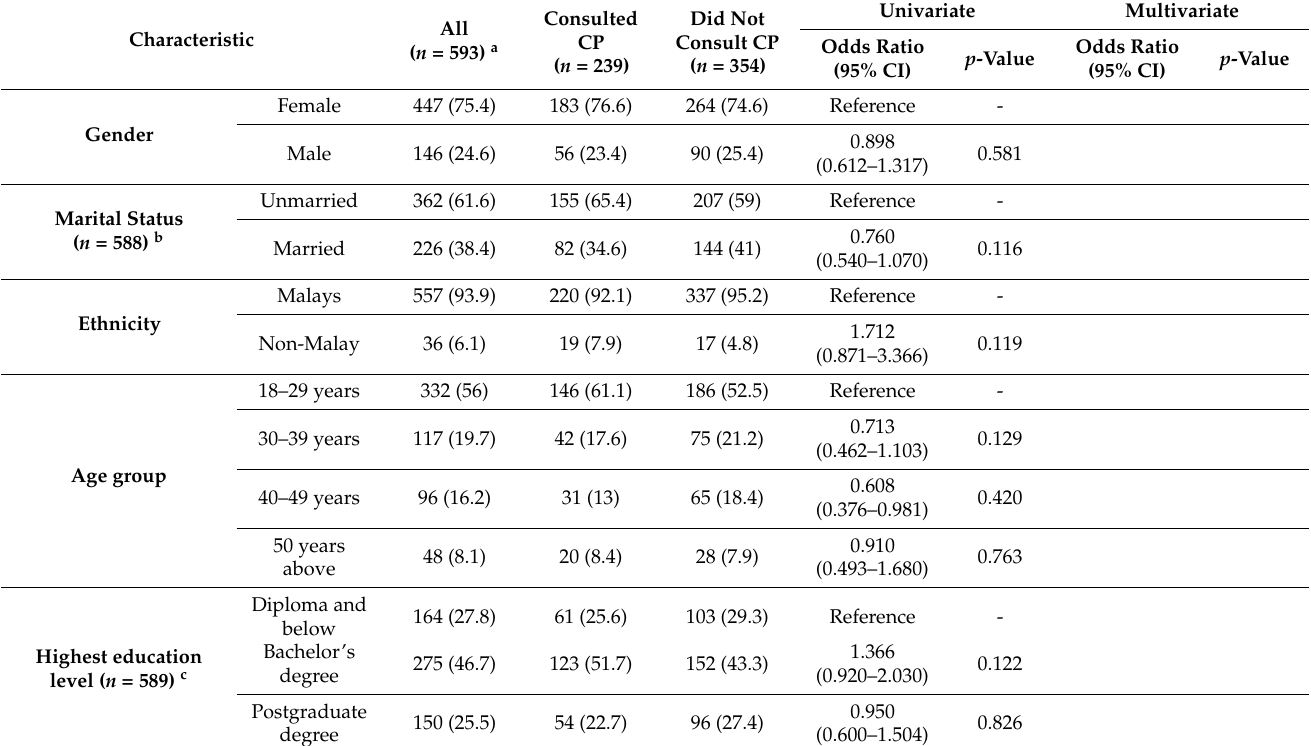
Table 1. The socio-demographic characteristics of the study respondents and comparison of the socio-demographic characteristics among those who consulted and did not consult CPs regarding HDSs ( n =